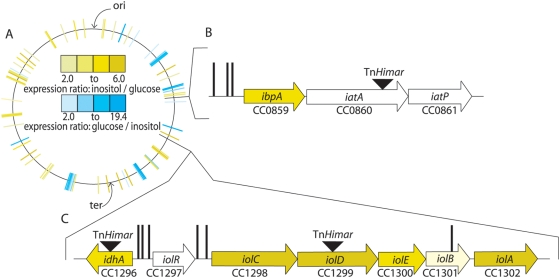
Genomic organization of the C. crescentus myo-inositol module and regulation of gene expression by myo-inositol and glucose.(A) Diagram of the C. crescentus chromosome with microarray expression data overlayed. Colored lines represent genes that are significantly up- (yellow) or down-regulated (blue) during growth on myo-inositol relative to glucose as the sole carbon source. The complete set of genes that are significantly up- or down-regulated in myo-inositol versus glucose can be found in Table S1. (B) Chromosomal organization of the myo-inositol transport operon, and (C) the myo-inositol degradation operon. Right-facing arrows indicate genes are on the plus strand of the chromosome; left-facing arrows indicate genes are on the minus strand. The color of the genes corresponds to their degree of regulation in myo-inositol relative to glucose (see color scale in the center of panel A). Black triangles represent locations of Himar transposon insertions identified in a forward screen for C. crescentus strains that cannot utilize myo-inositol as the sole carbon source. Vertical black lines indicate the location of the cis-acting regulatory motif GGAA-N6-TTCC (see Figure 4).